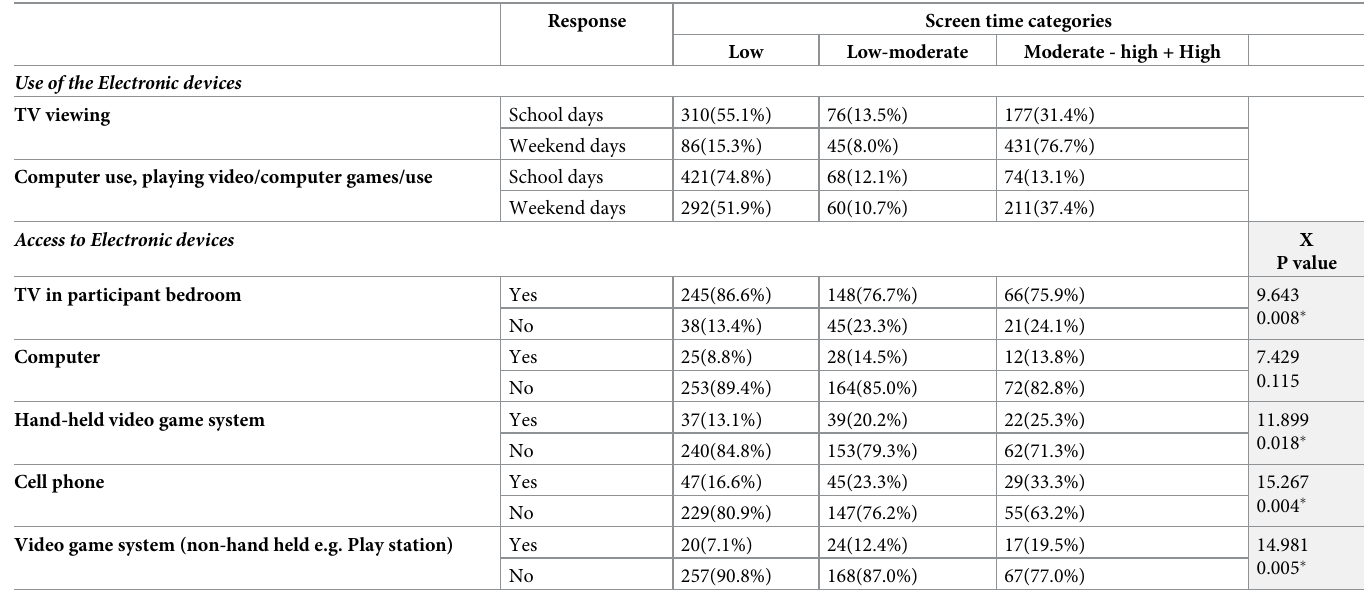
Table 3. Association of ST level and access/use of electronic devices.